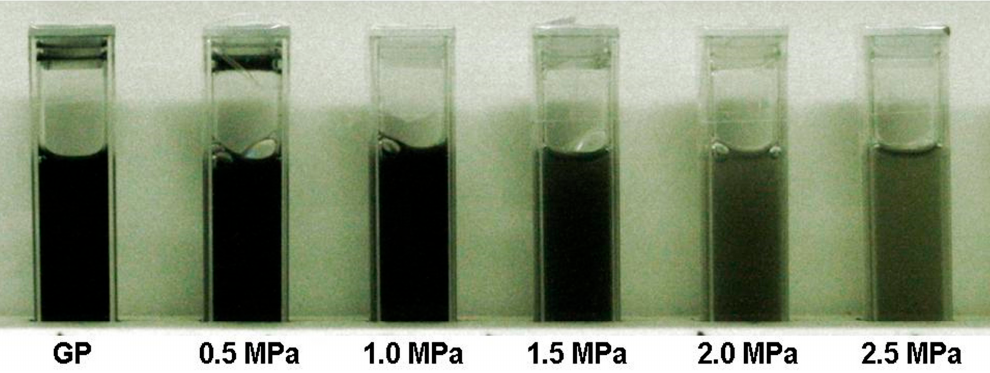
Figure 5. Photograph of the test samples. Table 1. Configuration of the experimental samples.